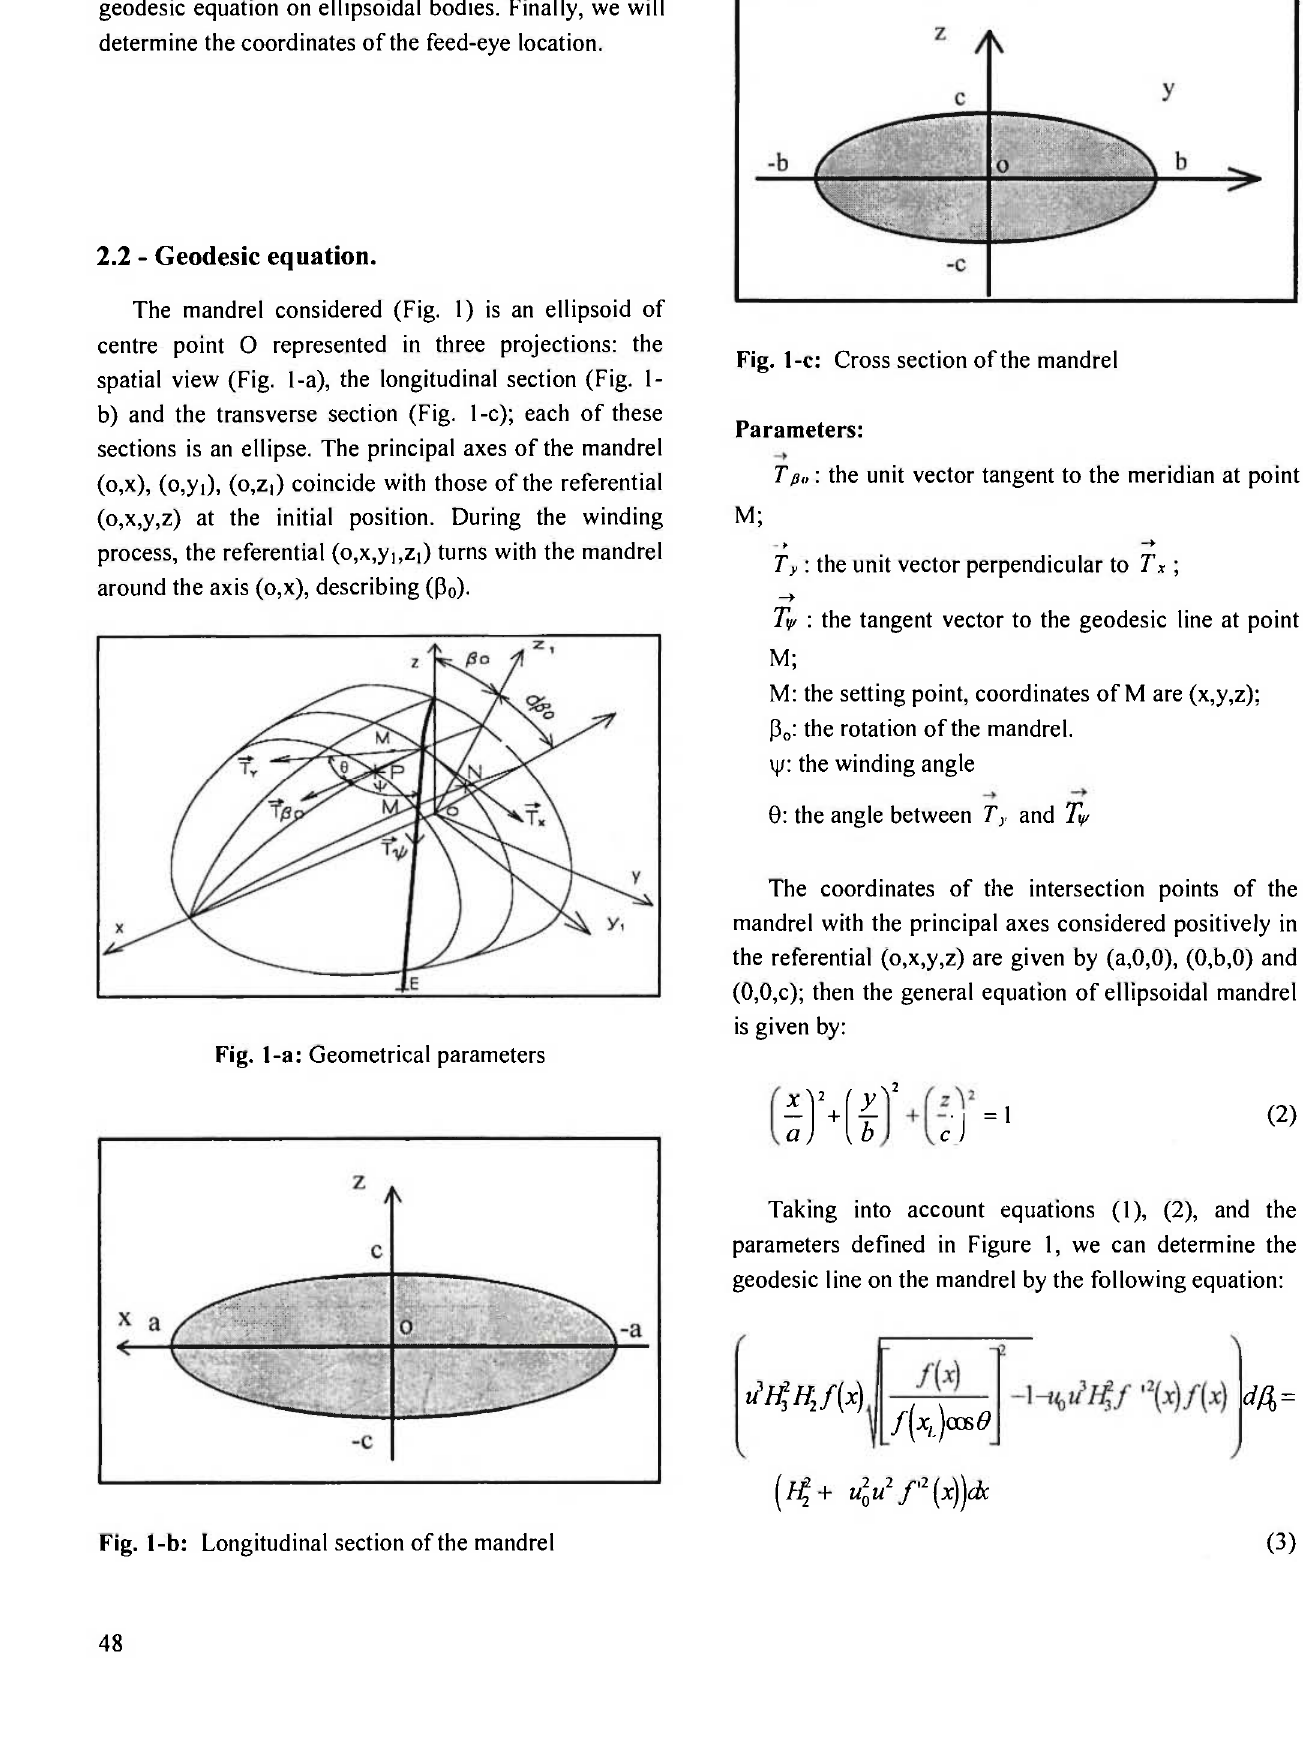
Fig. 1 -c: Cross section of the mandrel